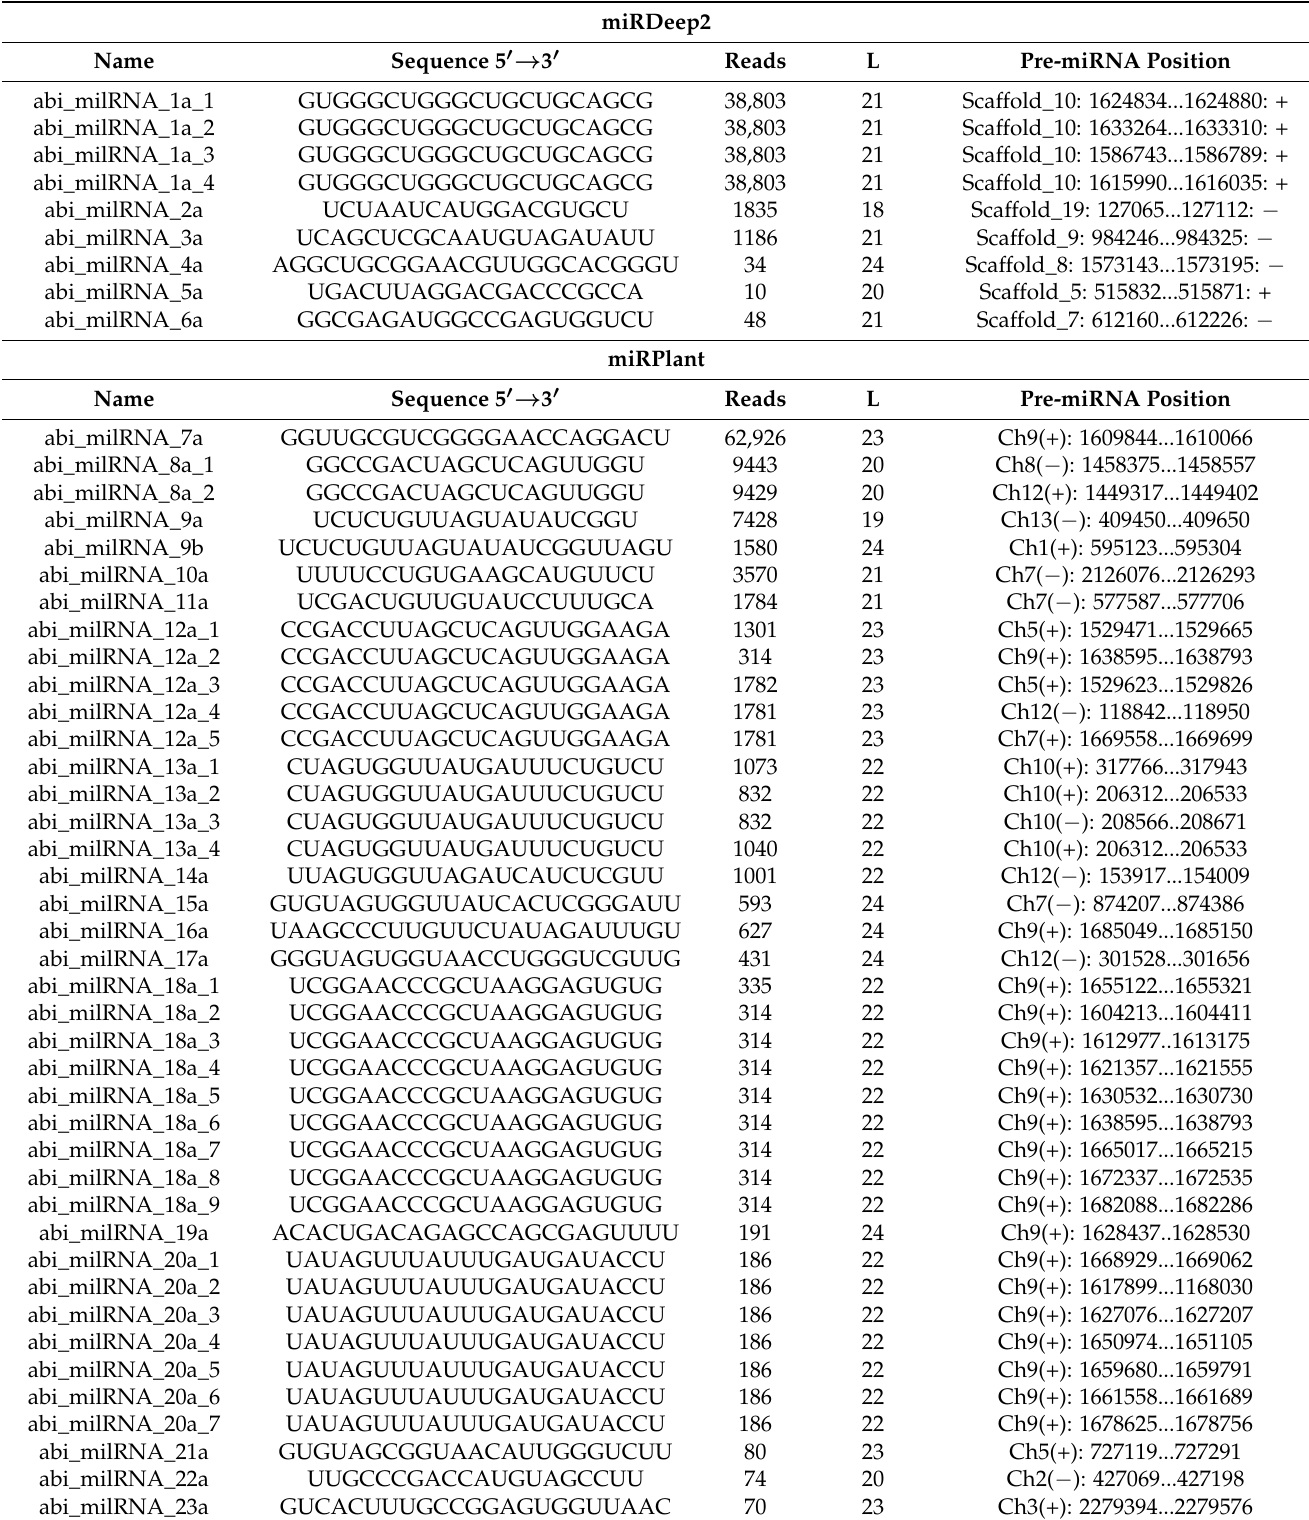
Table 2. Agaricus bisporus milRNA (microRNA-like) candidates predicted by miRDeep2 (and miARma-Seq) and miRPlant. Reads correspond to number of reads. L: length. Pre-miRNA po- sition corresponds to H97 assembly for miRDeep2 group and to H39 for miRPlant one.